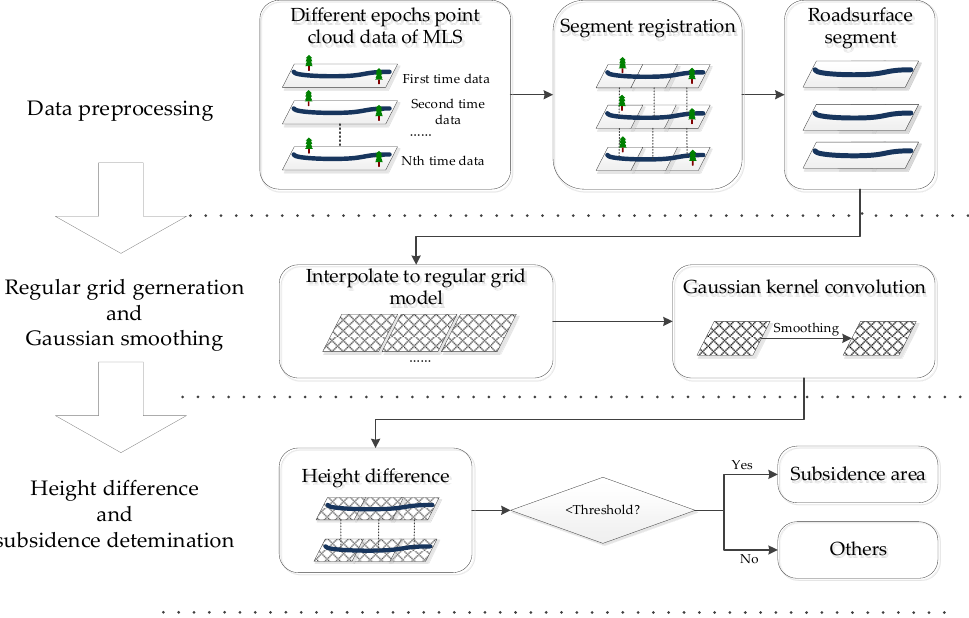
Figure 1. Data processing workflow.